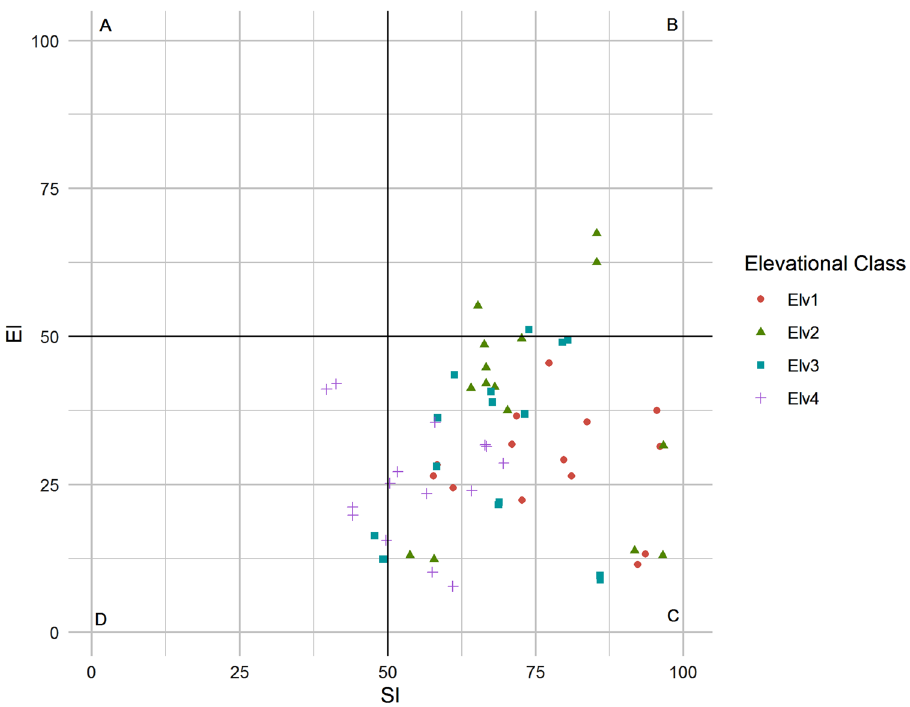
Figure 5. Food web diagnostic across Elevation classes. Elv1: 3000–3500 m; Elv2: 3501–4000 m; Elv3: 4001– 4500 m; Elv4: 4501–5000 m.